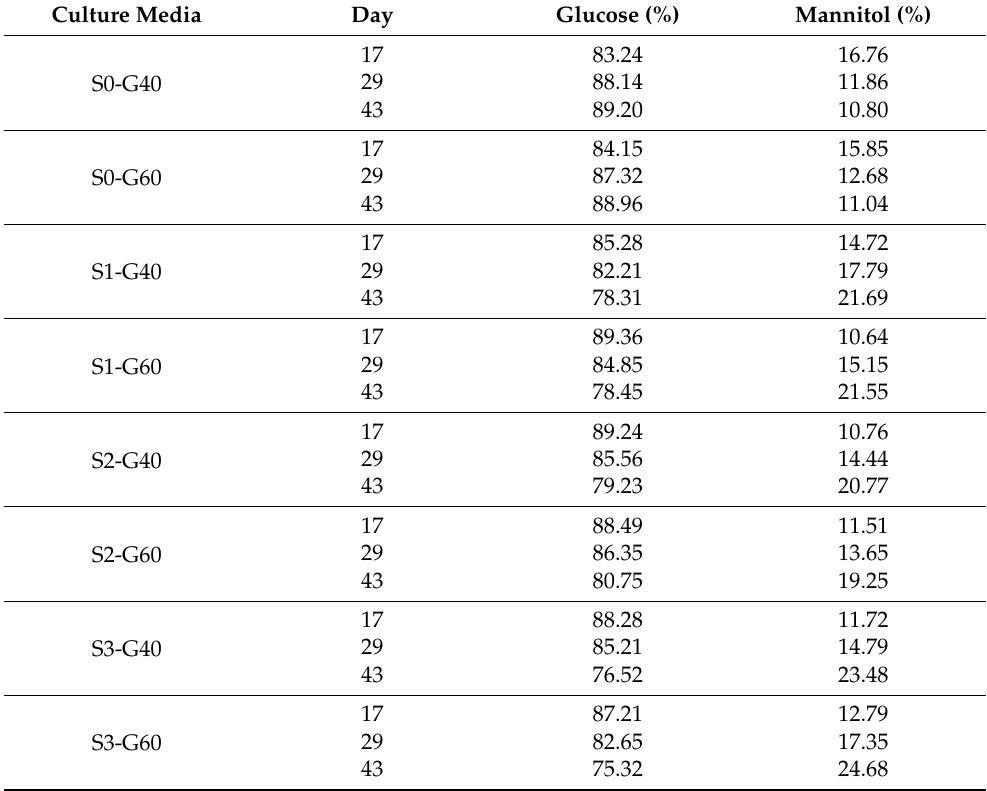
Table 4. Carbohydrate composition of total IPS produced by P. pulmonarius cultivated in static cultures in glucose (S0-G40, S0-G60) and OMWs (S1-G40, S2-G40, S3-G40 and S1-G60, S2-G60 and S3-G60; see Table 2)